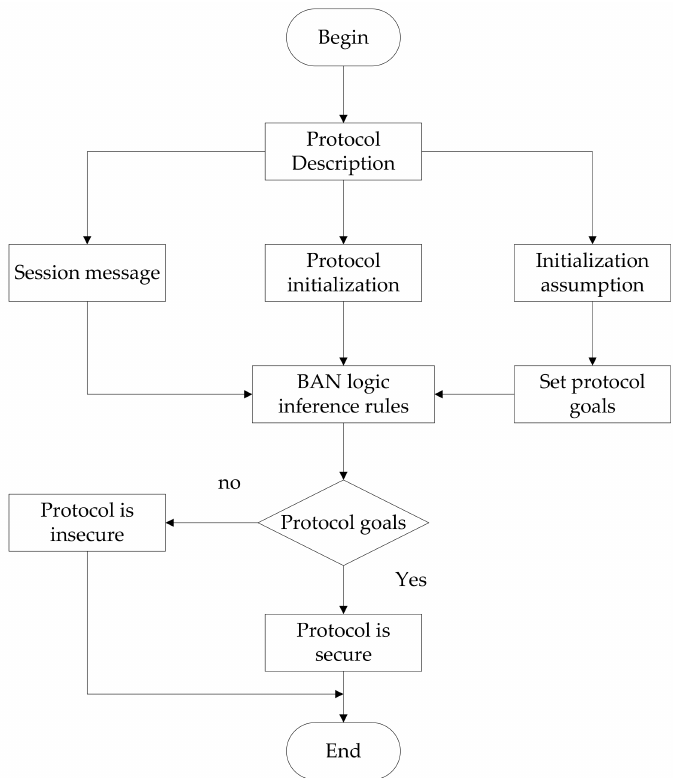
Figure 2. The detailed BAN logic inference